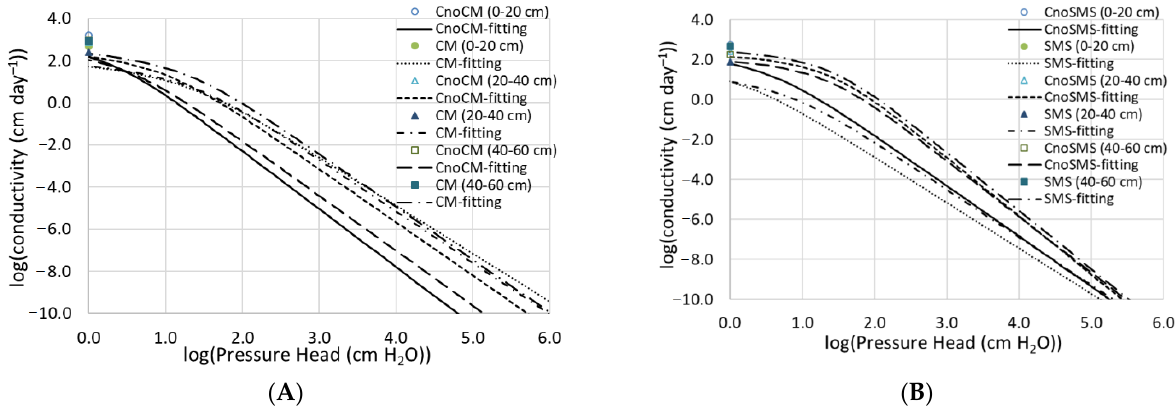
Figure 3. Fitted saturated and unsaturated hydraulic conductivity (as a function of the pressure head) at depths of 0–20, 20–40, and 40–60 cm. CM—chicken manure ( A ), SMS—spent mushroom substrate ( B ), CnoCM—control for the CM-amended soil, CnoSMS—control for the SMS-amended soil.